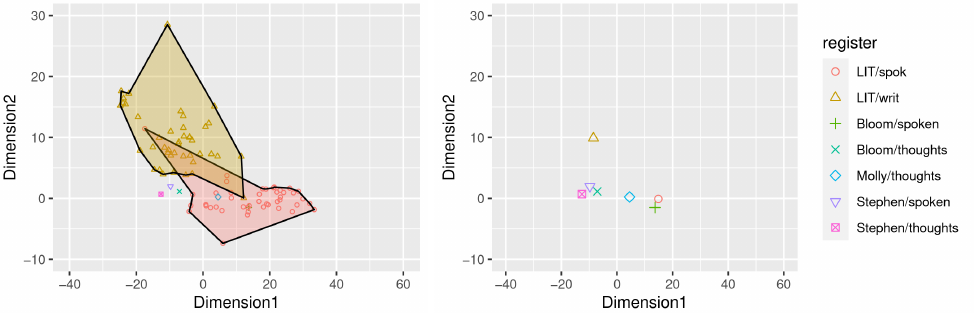
Figure 2. Dimension 1 and 2 scores according to the MAT for the narrative voice and fictional orality and the speech and thoughts of Bloom, Stephen, and Molly ( left : scores per text, right : mean